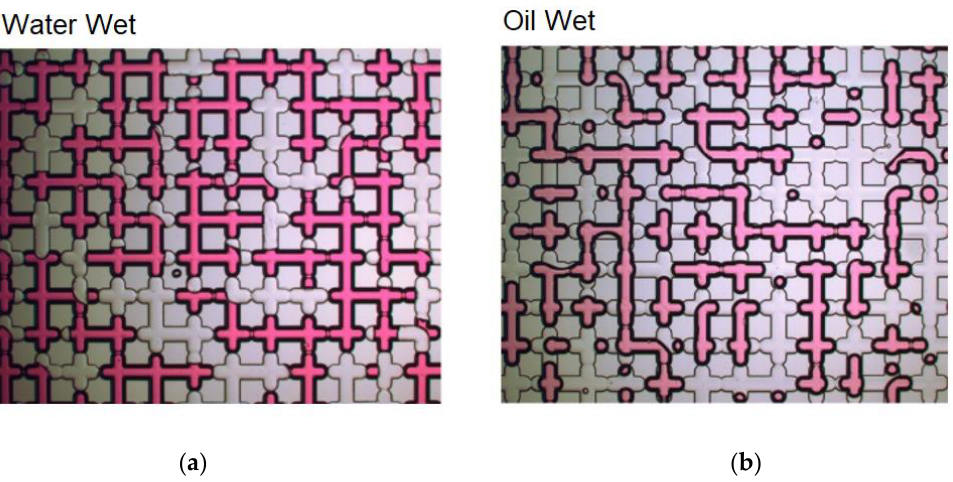
Figure 3. Detailed view of the pore space occupation after water injection: ( a ) water-wet (WW) micromodel; ( b ) oil-wet (OW) micromodel.